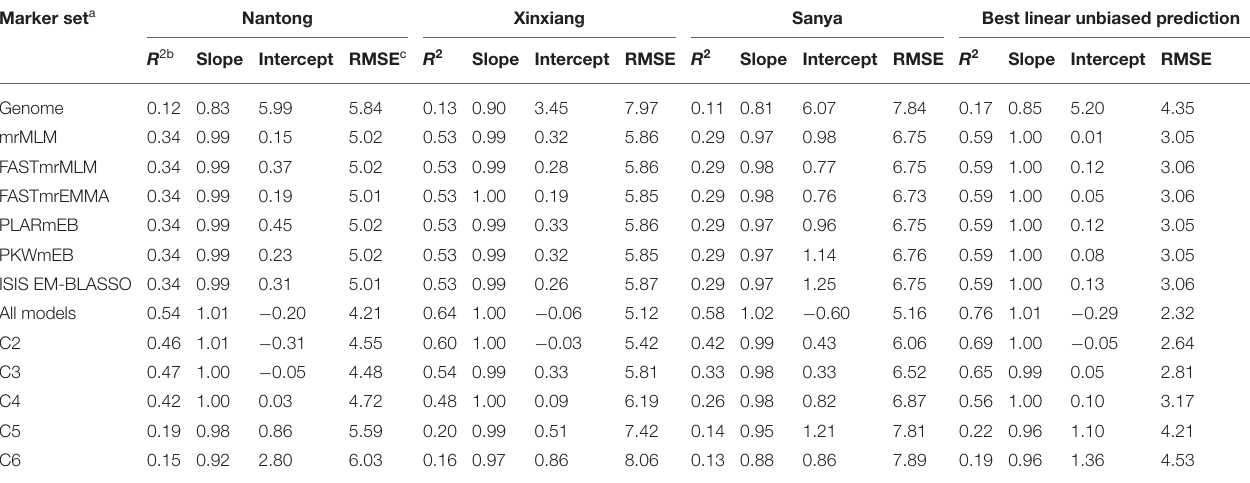
TABLE 3 | The prediction accuracy of the KMC when using markers in different ML-GWAS models in three environments and BLUP. Marker set a Nantong Xinxiang Sanya